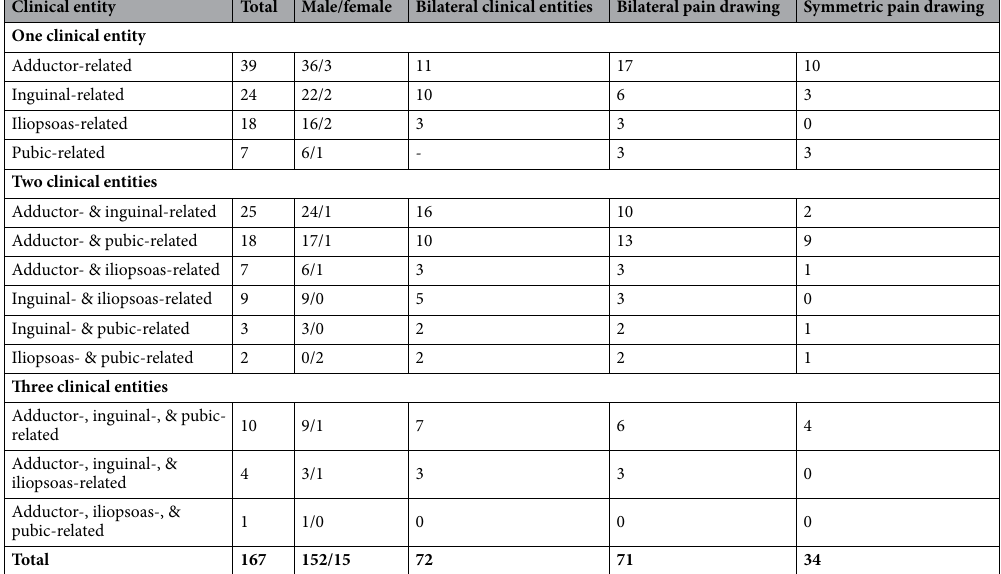
Table 2. Summary of diagnosed clinical entities, gender proportion, prevalence of bilateral clinical entities, bilateral pain drawings (pain drawed across the midline of the body), and symmetric pattern of pain (drawing covers the same areas on each side to a high extent). Reported as number of patients.